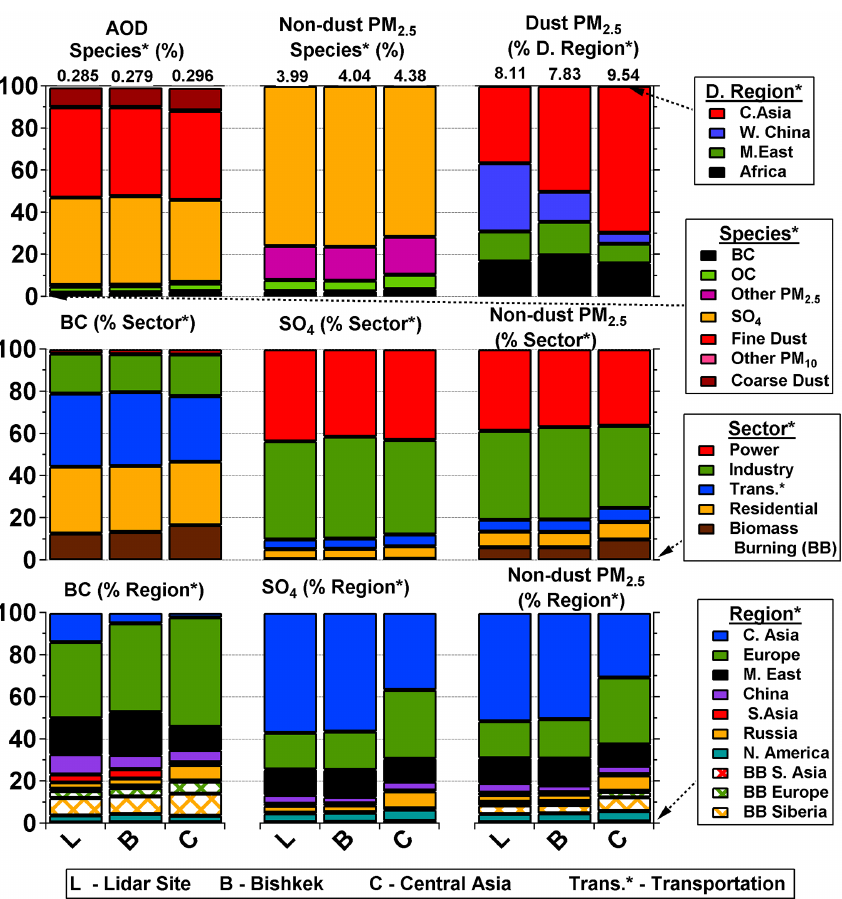
Figure 7. Summary of period mean contributions by source regions and sectors for AOD, PM 2 . 5 , dust, non-dust PM 2 . 5 , sulfate, and BC in percent for the grid cells containing the Bishkek and LST observation sites, and spatially averaged over the Central Asia region. See Fig. 1 for anthropogenic, dust, and fire source regions. “Lidar” denotes the LST